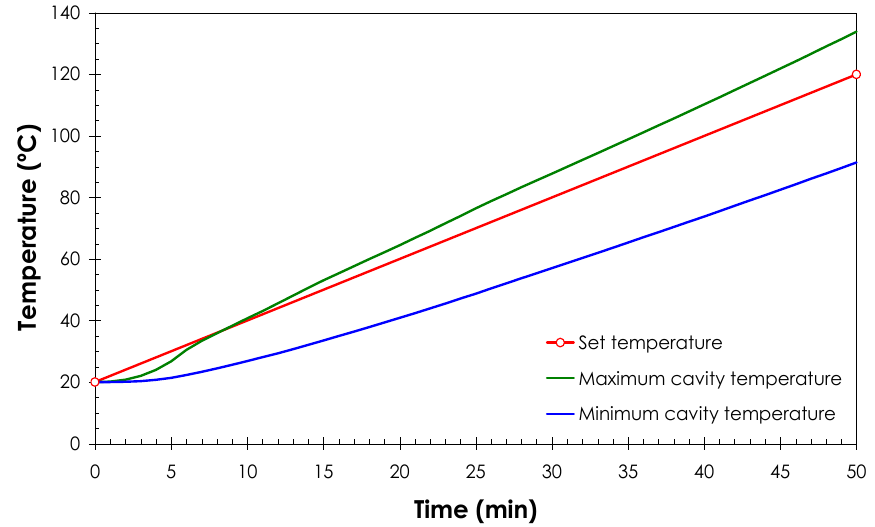
Figure 9. Evolutions of the maximum and minimum temperatures of the cavity.